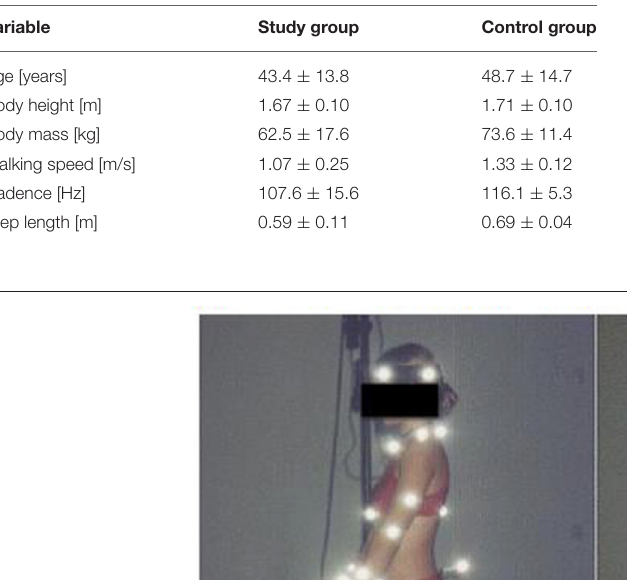
TABLE 2 | Characteristics of the study and control group.